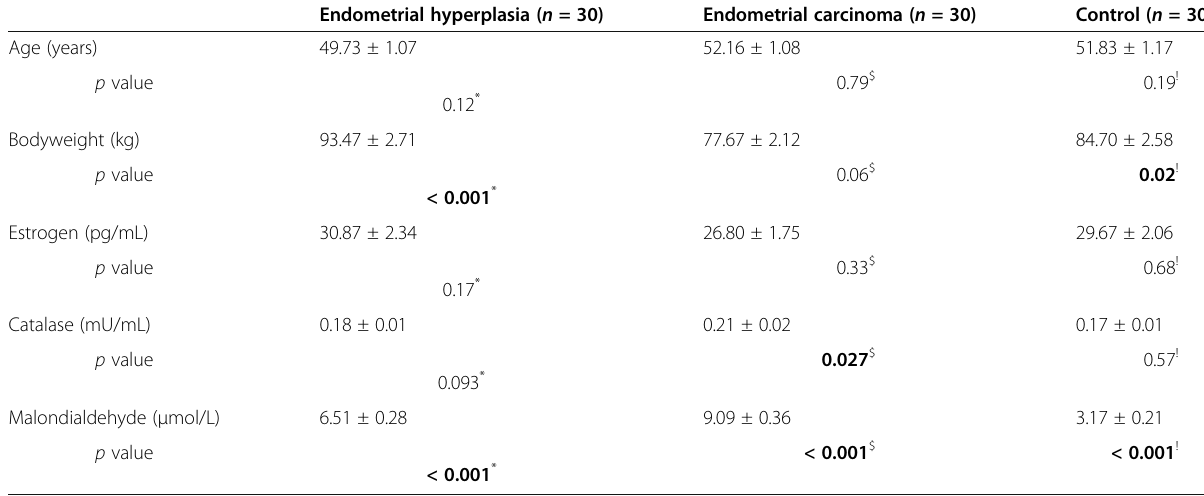
Table 1 Demographic and biochemical data of the studied